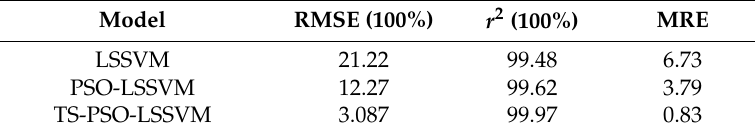
Table 6. The calculation results of the three